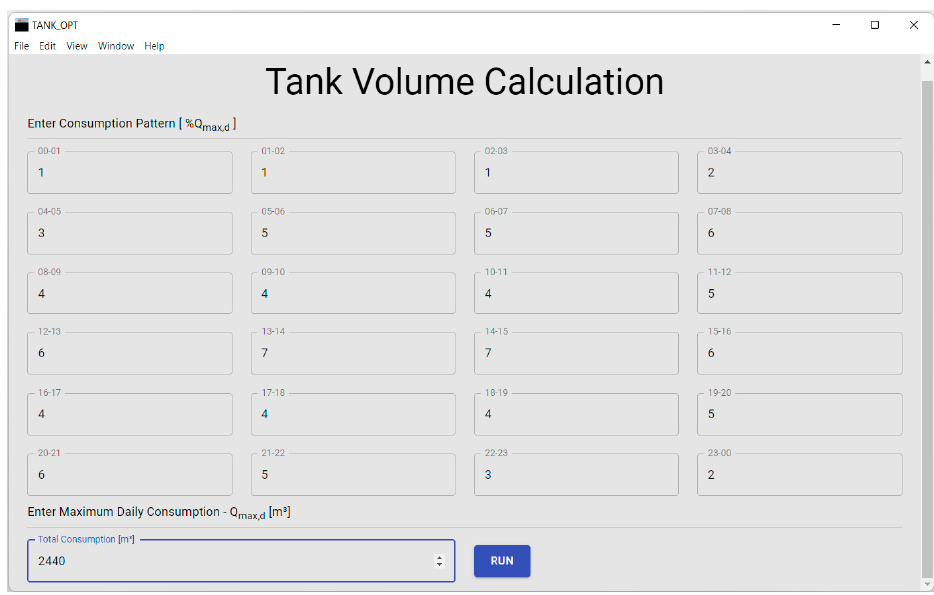
Figure 8. Screenshot of startup and input fields of the created application with entered values for Variant I.